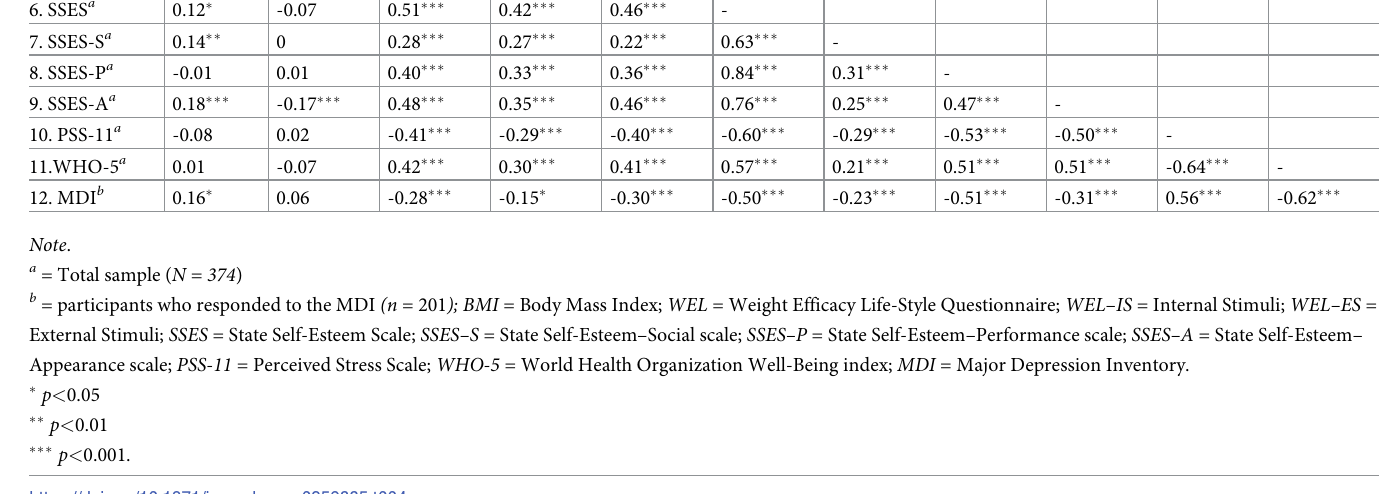
2.2.4. Relationships with sociodemographic and psychological variables. Analysis of the univariate and multivariate normalities indicated that the data from the SSES, PSS-11, WHO-5 and MDI questionnaires and their subscales were not distributed normally (Mardia’s coefficient: | z | > 5, Shapiro normality test: p < 0.001). Therefore, the study of the links between the variables was carried out using nonparametric Spearman rhô correlation coeffi- cients. Correlation coefficient values are presented in Table 4.